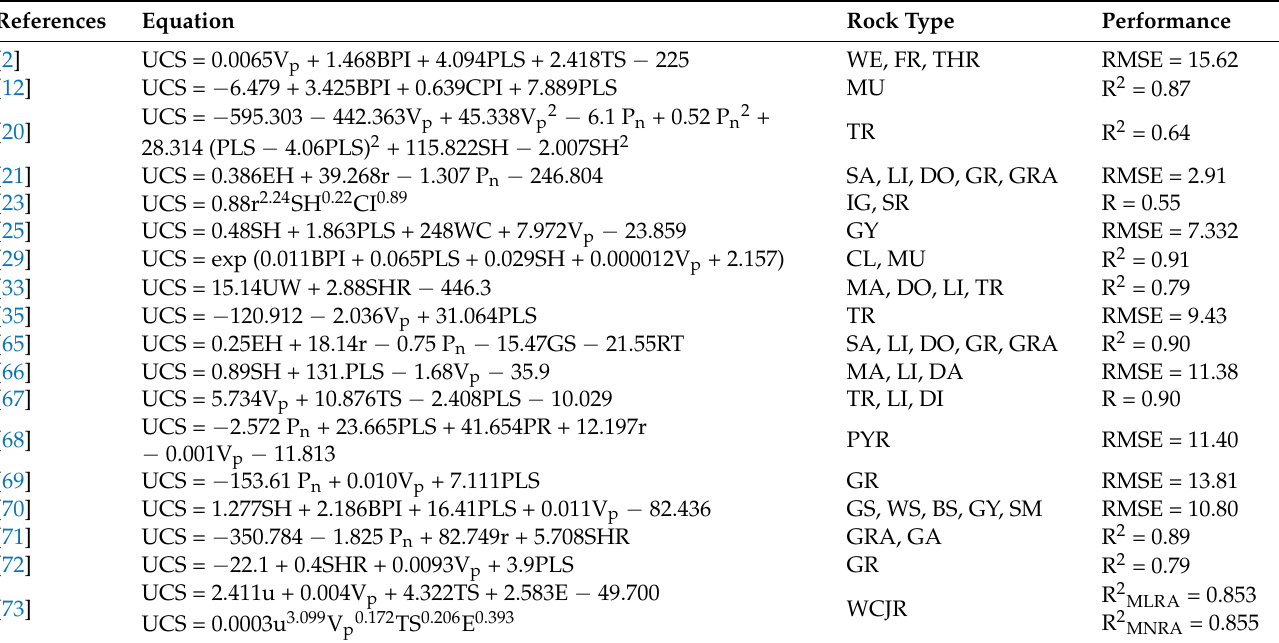
Table 1. Multiple regression analysis (MR) for predicting